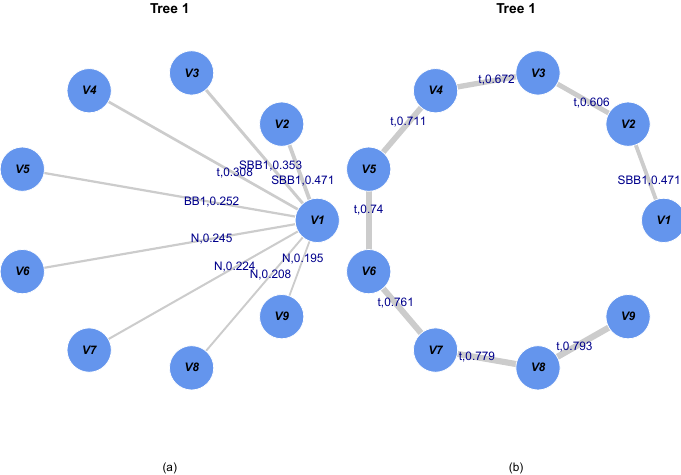
Figure 4. ( a ) First tree of C-vine for the observed record values; ( b ) first tree of D-vine for the observed record values. The labels are the best pair-copula families and corresponding Kendall’s τ values. For example, N, t, BB1, and SBB1 represent Gaussian, Student t, Clayton Gumbel, and survival Clayton Gumbel copula,